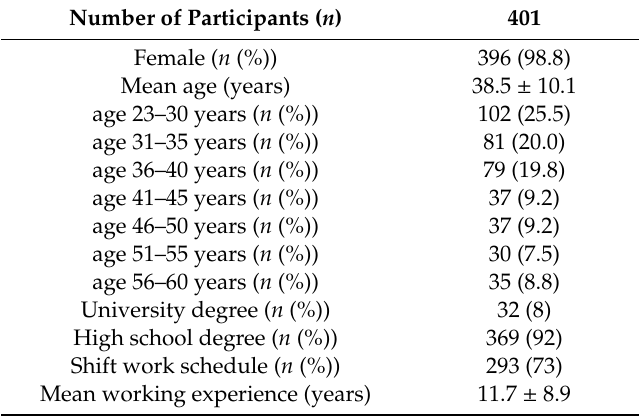
Table 2. Characteristics of the whole population of